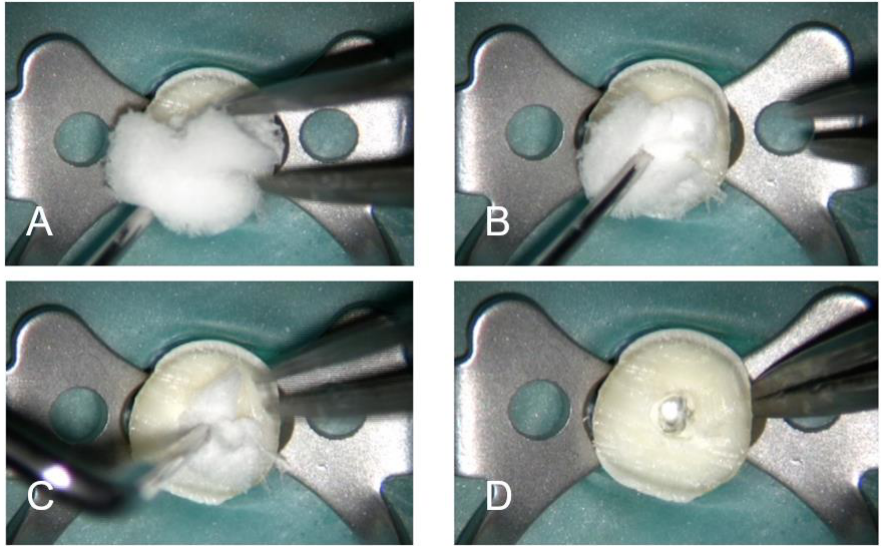
Figure 1. ( A ) Placement of the sponge at the canal entry. ( B , C ) Compaction at the coronal and middle third of the root. ( D ) Collagen sponge properly placed at the apical third of the root.